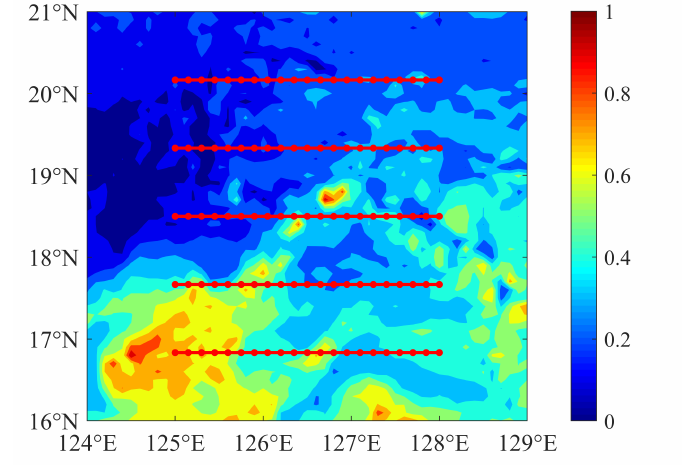
Figure 11. The control group used to test the observation